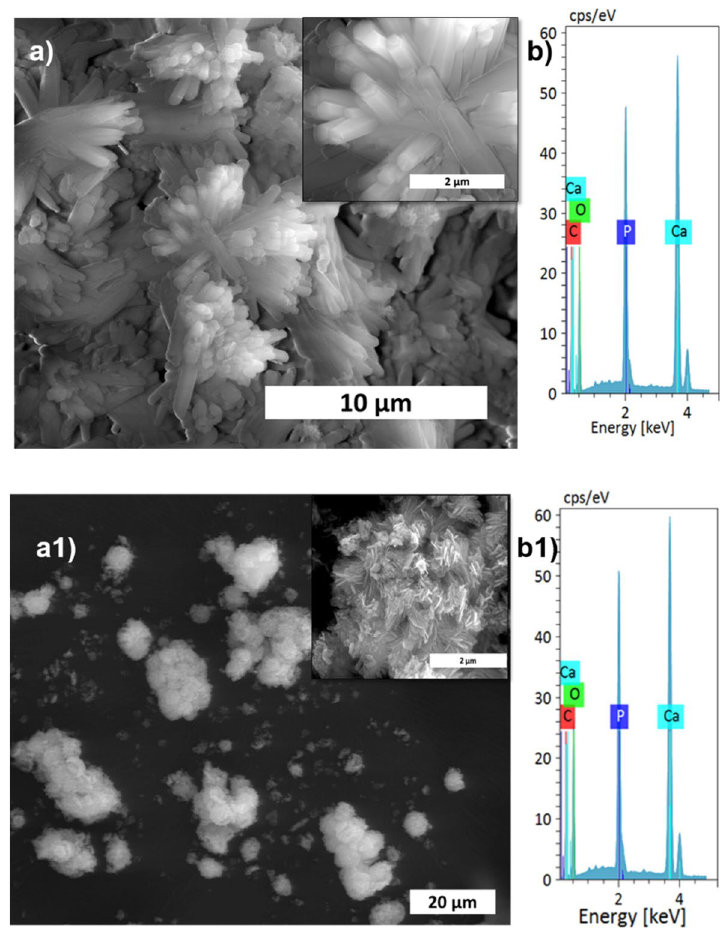
Figure 3. SEM analysis ( a,a1 ), and its magnified images (insert), with EDS spectrum ( b,b1 ) of S1, and S4 samples, respectively.